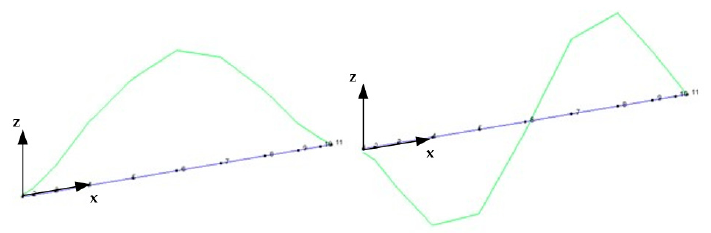
Figure 9. The first two experimentally-obtained mode shapes of the reference iron tie rod 6B ‒ C.